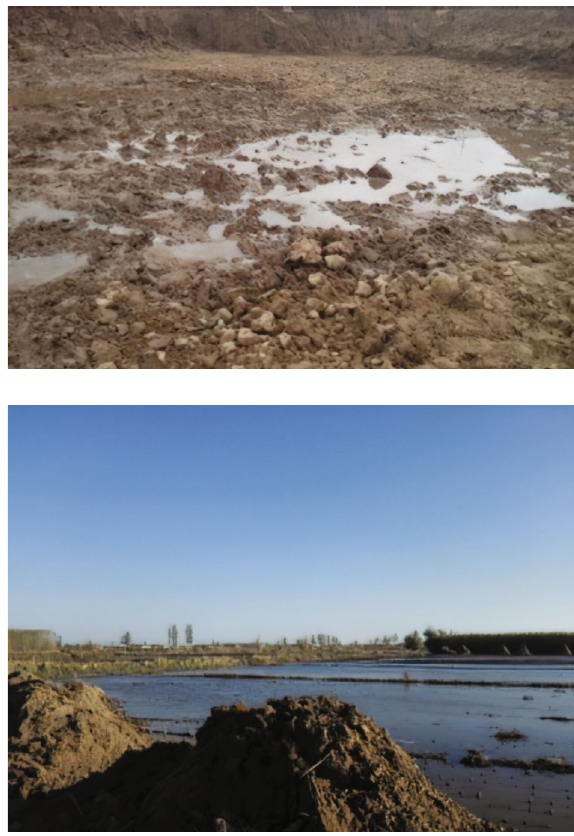
Figure 1: Surface water on site. Table 1: Physical and mechanical properties of bad geological soils in the Hetao